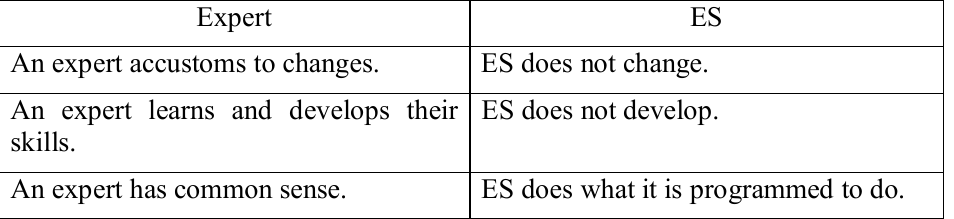
Table 2 – Disadvantages of process management based on ES Expert